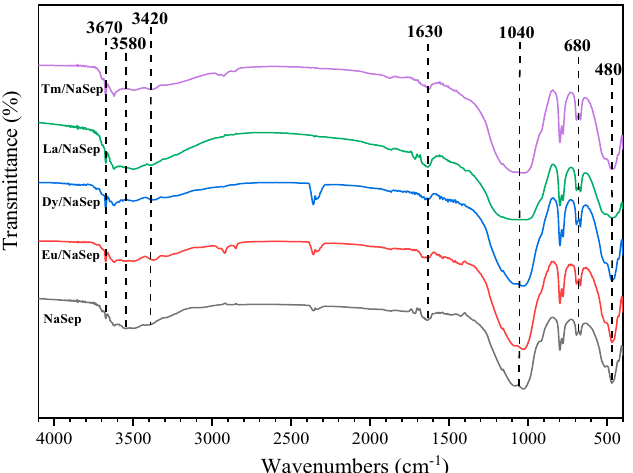
Figure 2. FTIR spectra of NaSep, Eu/NaSep, Dy/NaSep, La/NaSep, and Tm/NaSep.